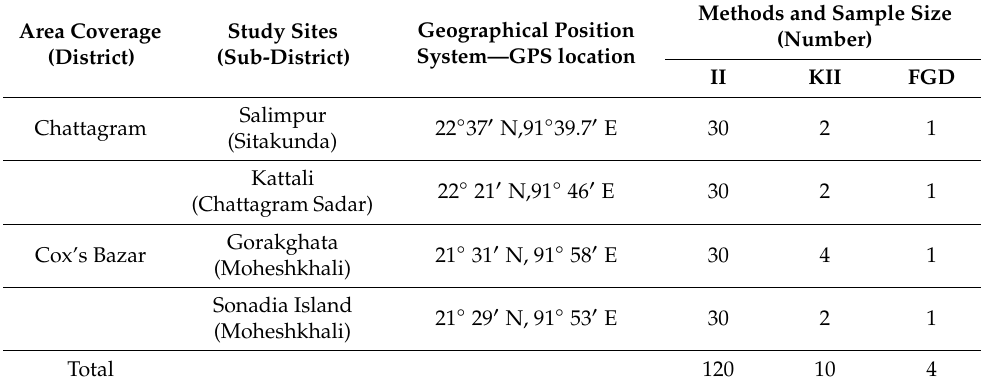
Table 2. Area coverage, site location, sample size, methods, and tools employed in the